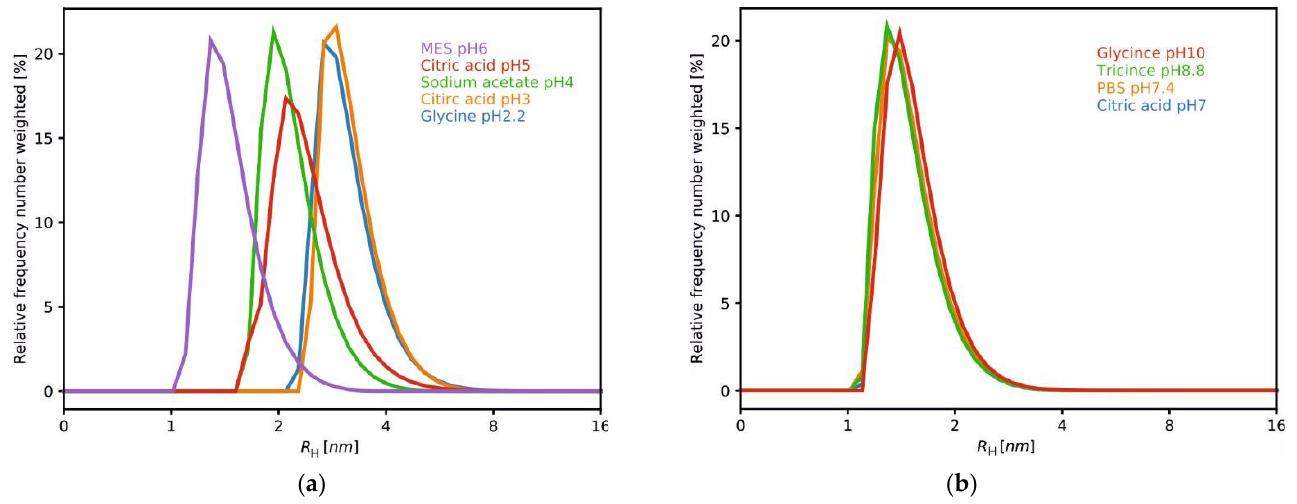
Figure 3. DLS data collected for human cystatin C at different pH levels: ( a ) DLS results—particle size distribution of human cystatin C (HCC) in various buffers; ( b ) pH dependence (range 2.2 – 6); ( b ) pH dependence (range 7 – 10).